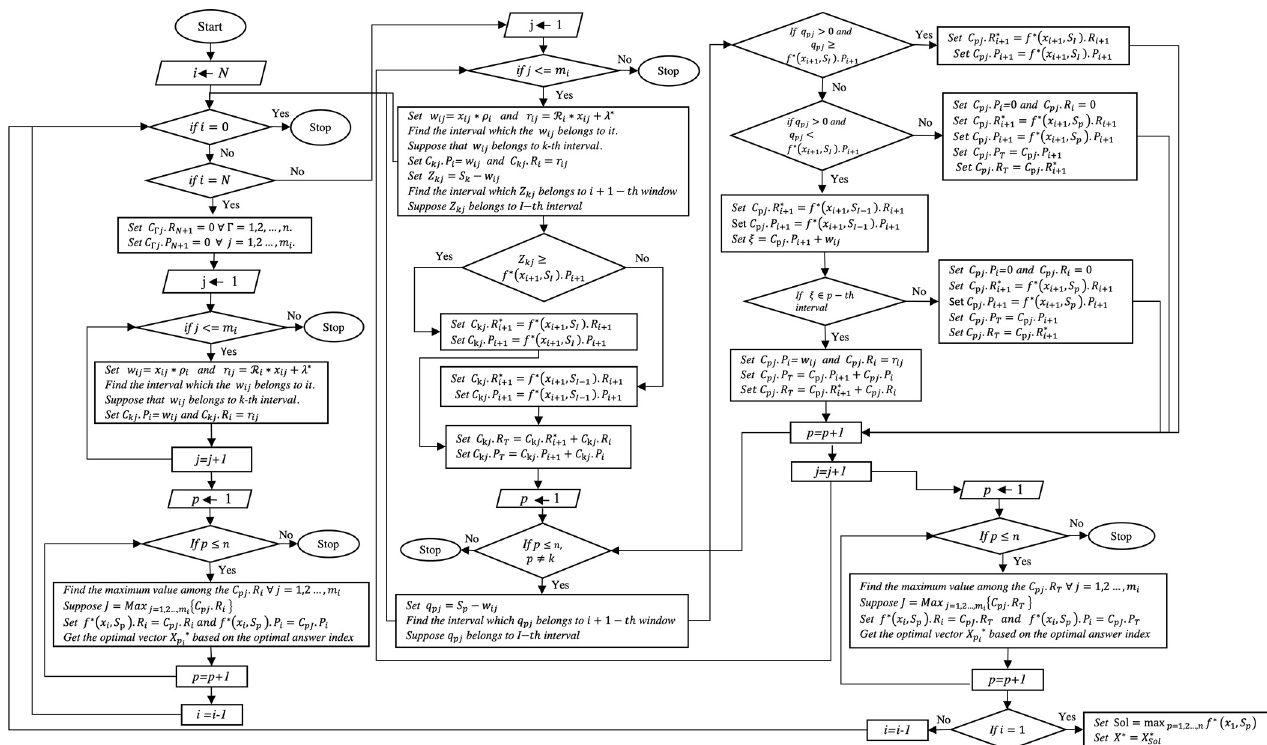
Fig 2. Flowchart of the proposed algorithm.